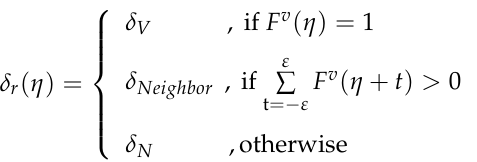
Frame index Figure 3. Contour of the estimated noise power for a sub-band of speech (spoken by a female speaker, interfered by white noise with an average SegSNR = 10 dB). Blue line: Power of noisy speech; green dotted line: true noise; red dotted line: estimated by the MCRA method; black solid line: proposed method. In the case of non-stationary noise interference, such as factory noise, the proposed method also performs well in noise estimation shown in Figure 4. By comparing the estimated magnitude of noise contours for the MCRA and proposed methods, the level of the proposed method is lower